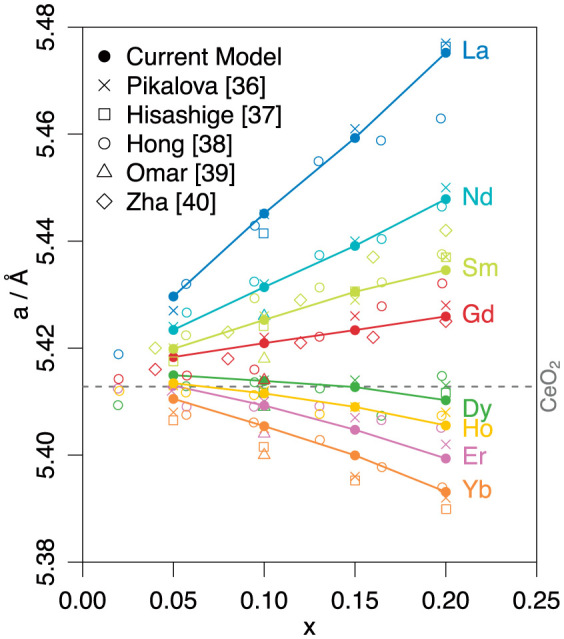
Variation in lattice parameter predicted by model for Ce1-xRxO2-½x as function of dopant concentration x at T = 300 K.Molecular dynamics data is plotted with the experimental values3637383940. Dashed grey line indicates the 300 K lattice parameter predicted by the model for undoped CeO2.